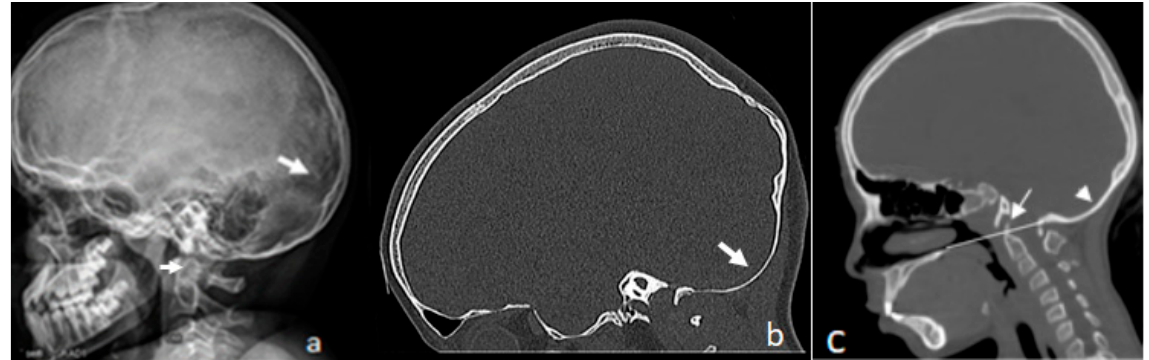
Figure 1. ( a – c ): Lateral skull radiograph of the 10-year-old boy with OI type I showing frontal bossing and abundance of worm-like phenotype over lambdoid sutures (arrow); note the odontoid hypoplasia (arrow head), atlanto-axial instability and hypoplastic posterior arch of the atlas. His genotype exhibited mutation COL1A2 p.G1078D ( a ). Sagittal reformatted CT scan of the cranium of a 12-year-old boy with OI type I showing massive downward thinning of the occipital area (downward bulging of the occipital lobe of the cerebrum) in connection with progressive softening of the fragile lambdoid sutures (arrow). He manifested mutation in COL1A1 , showing c.3233 G>A ( b ). Sagittal CT scan of the cranium of a 15-year-old boy with OI type I showing bulging of the odontoid process of 6 mm above Chamberlain’s line, signifying basilar impression (arrow). Note the redundancy and downward bulging of the occipital area (occipital lobe of the cerebrum) in connection with progressive thinning/softening of the lambdoid sutures, arrow head). His genotype demonstrated mutation in COL1A2,pGly634Asp ( c